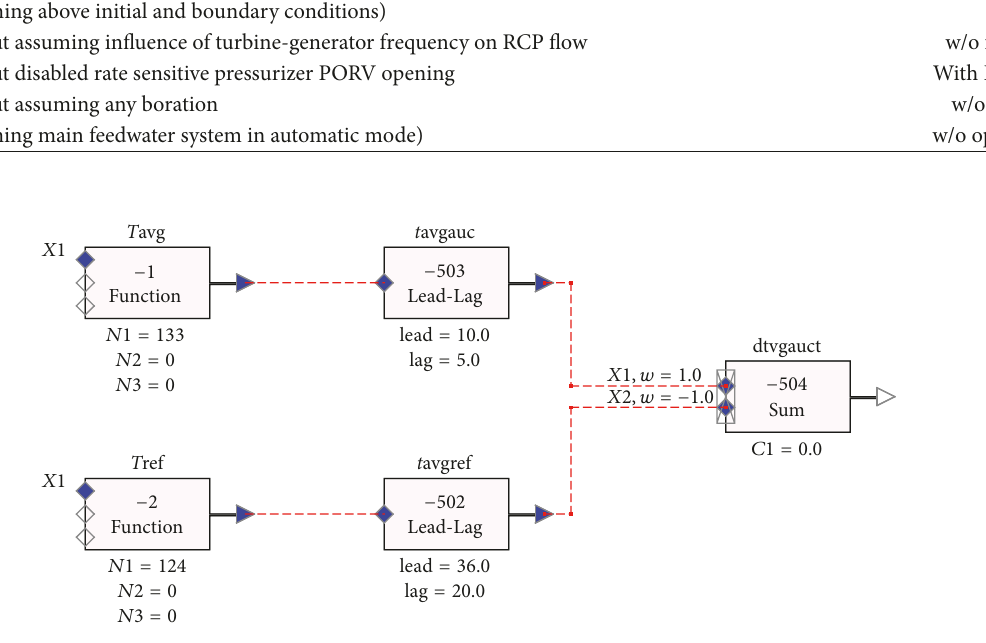
Figure 4: TRACE model of the input part of steam dump load rejection